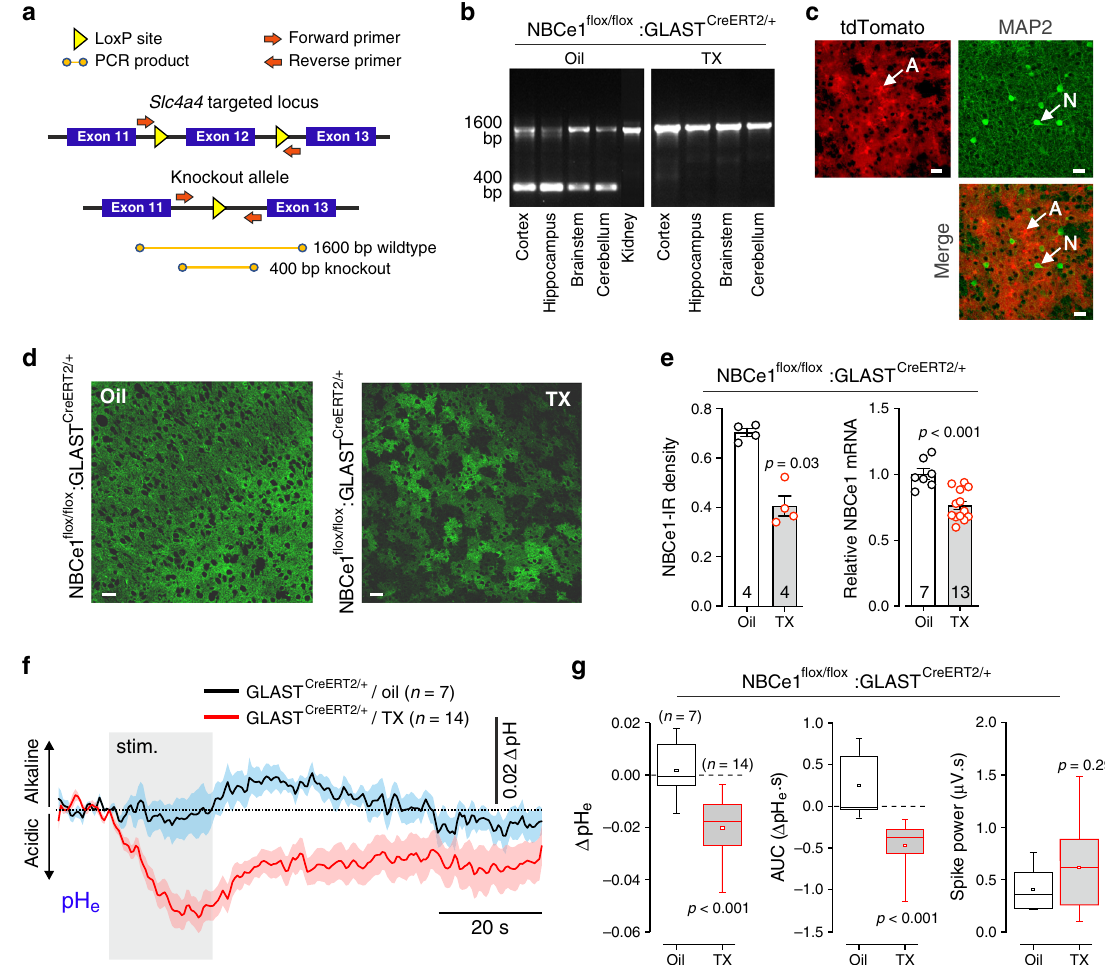
Fig. 7 Astroglial NBCe1 is essential for the regulation of brain extracellular pH. a Genotyping strategy used to determine the ef fi cacy of recombination and deletion of exon 12 of Slc4a4 locus. The expected wild-type and gene knockout products are 1600 bp and 400 bp, respectively. b PCR-products showing the recombination status of Slc4a4 locus in different brain regions of vehicle (oil) and tamoxifen (TX)-treated NBCe1 fl ox/ fl ox /GLAST CreERT2/ + mice. Wild-type fragment is present across all the samples while the knockout band is present only in the brain tissue samples con fi rming speci fi c induction of recombination in astrocytes. c Mosaic expression of the reporter gene (tdTomato) in protoplasmic cortical astrocytes (A). Neurons (N) were identi fi ed by MAP2 immunostaining. Scale bars = 20 µ m. d Knockdown of NBCe1 expression in cortical astrocytes. Confocal images illustrate